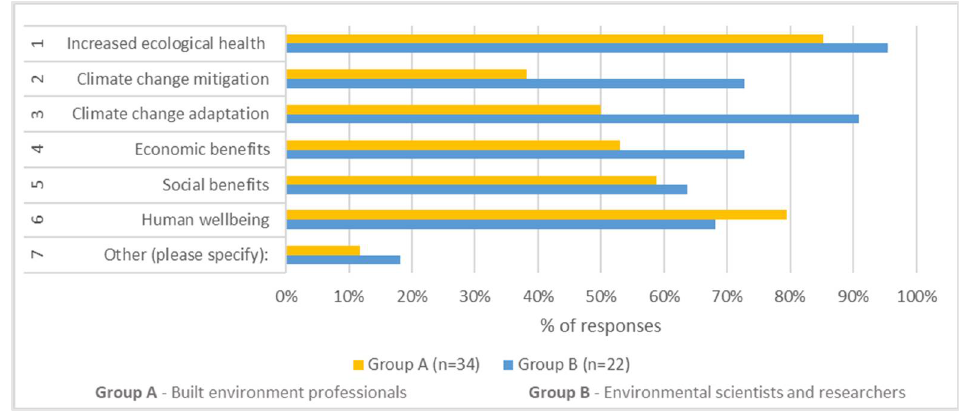
Figure 17. Co-benefits of sequestering carbon and providing habitat using vegetation in the built environment.